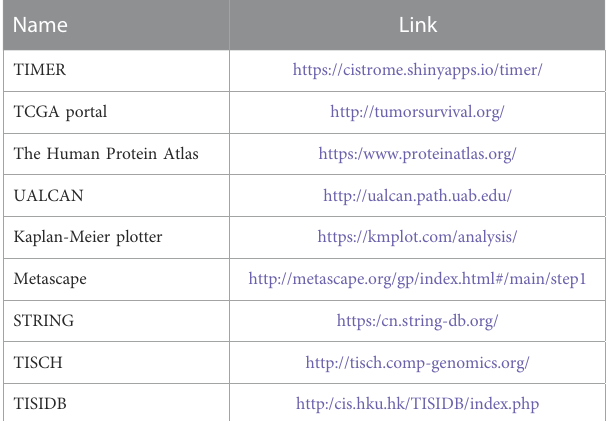
TABLE 1 Summary of databases used in this